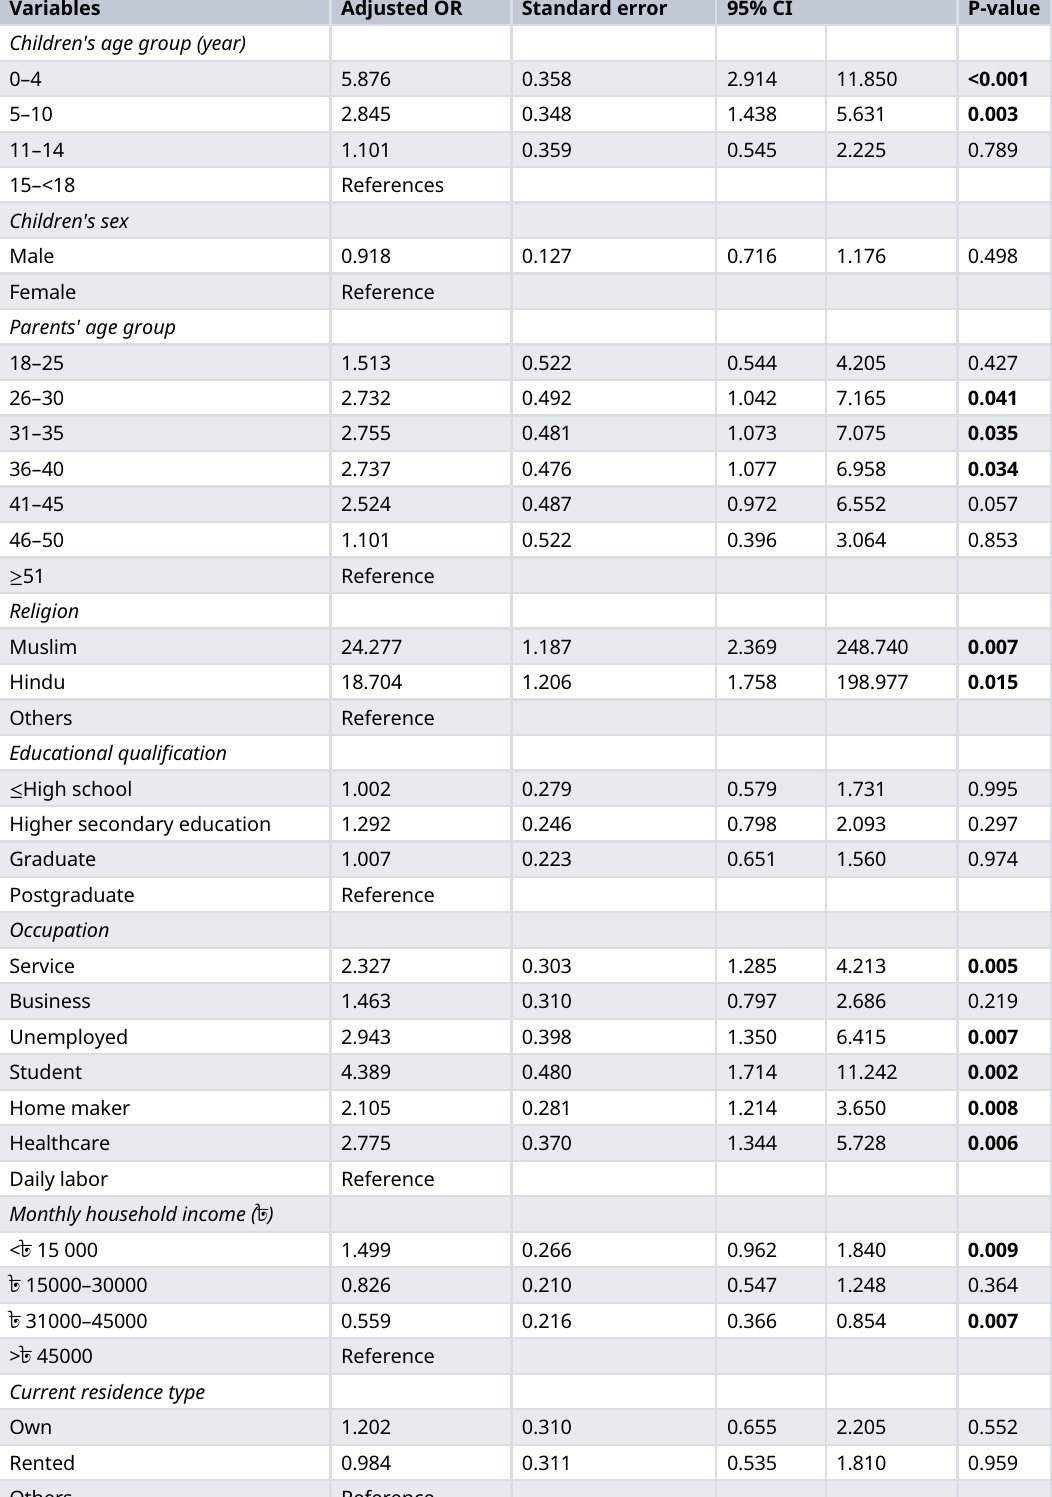
Table 2. Binary logistic regression: predictors of parental vaccine hesitancy in study